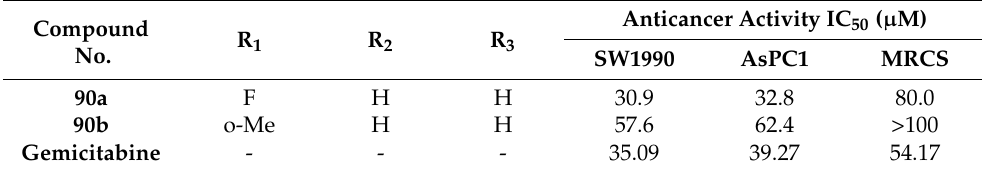
Figure 87. Structure of benzimidazole ‐ pyrazole derivatives ( 90 ). Table 76. In vitro cytotoxic activities of benzimidazole ‐ pyrazole hybrid compounds 90 (a ‐ b).